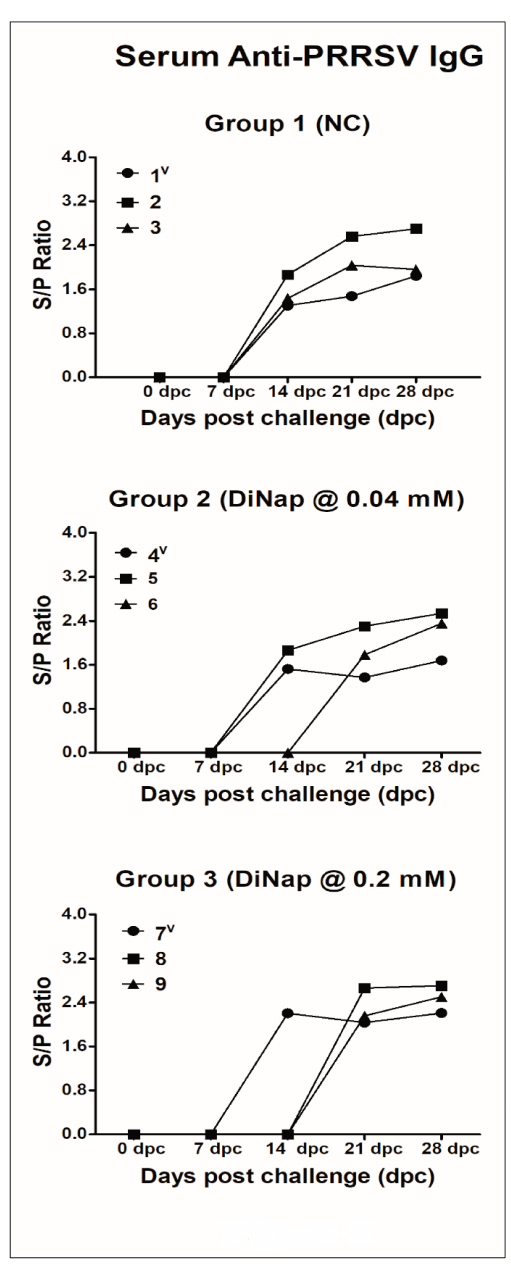
Figure 3. Anti-PRRSV antibody (IgG) responses measured by enzyme-linked immunosorbent assay (ELISA) in the pigs in each group. PRRSV-specific antibodies (IgG) were detected in the serum samples by using a commercially available ELISA kit (IDEXX PRRS X3 Ab Test). An S/P ratio (ratio between the net optical density of the test samples and the net optical density of the positive control) ≥ 0.4 was considered positive for the PRRSV antibody. The results are expressed as the S/P ratio of the samples, with S/P ≥ 0.4 considered positive for the PRRSV antibody (IgG). Note: v indicates the pig challenged with virus in each